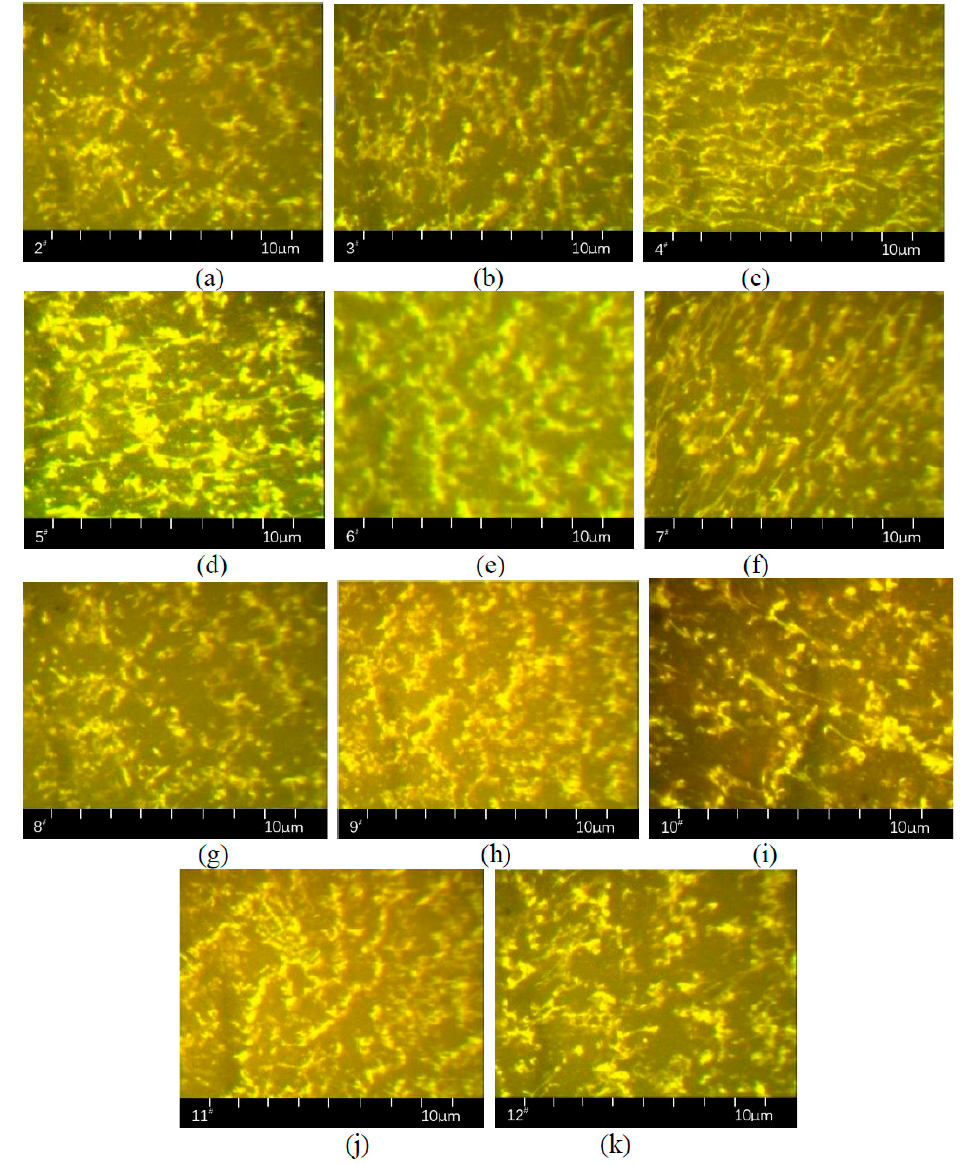
Figure 5. The representative RGB of direct-to-plant SBS modified bitumen modifier: ( a ) 2 # , ( b ) 3 # , ( c ) 4 # , ( d ) 5 # , ( e ) 6 # , ( f ) 7 # , ( j ) 8 # , ( h ) 9 # , ( i ) 10 # , ( j ) 11 # and ( k ) 12 # .